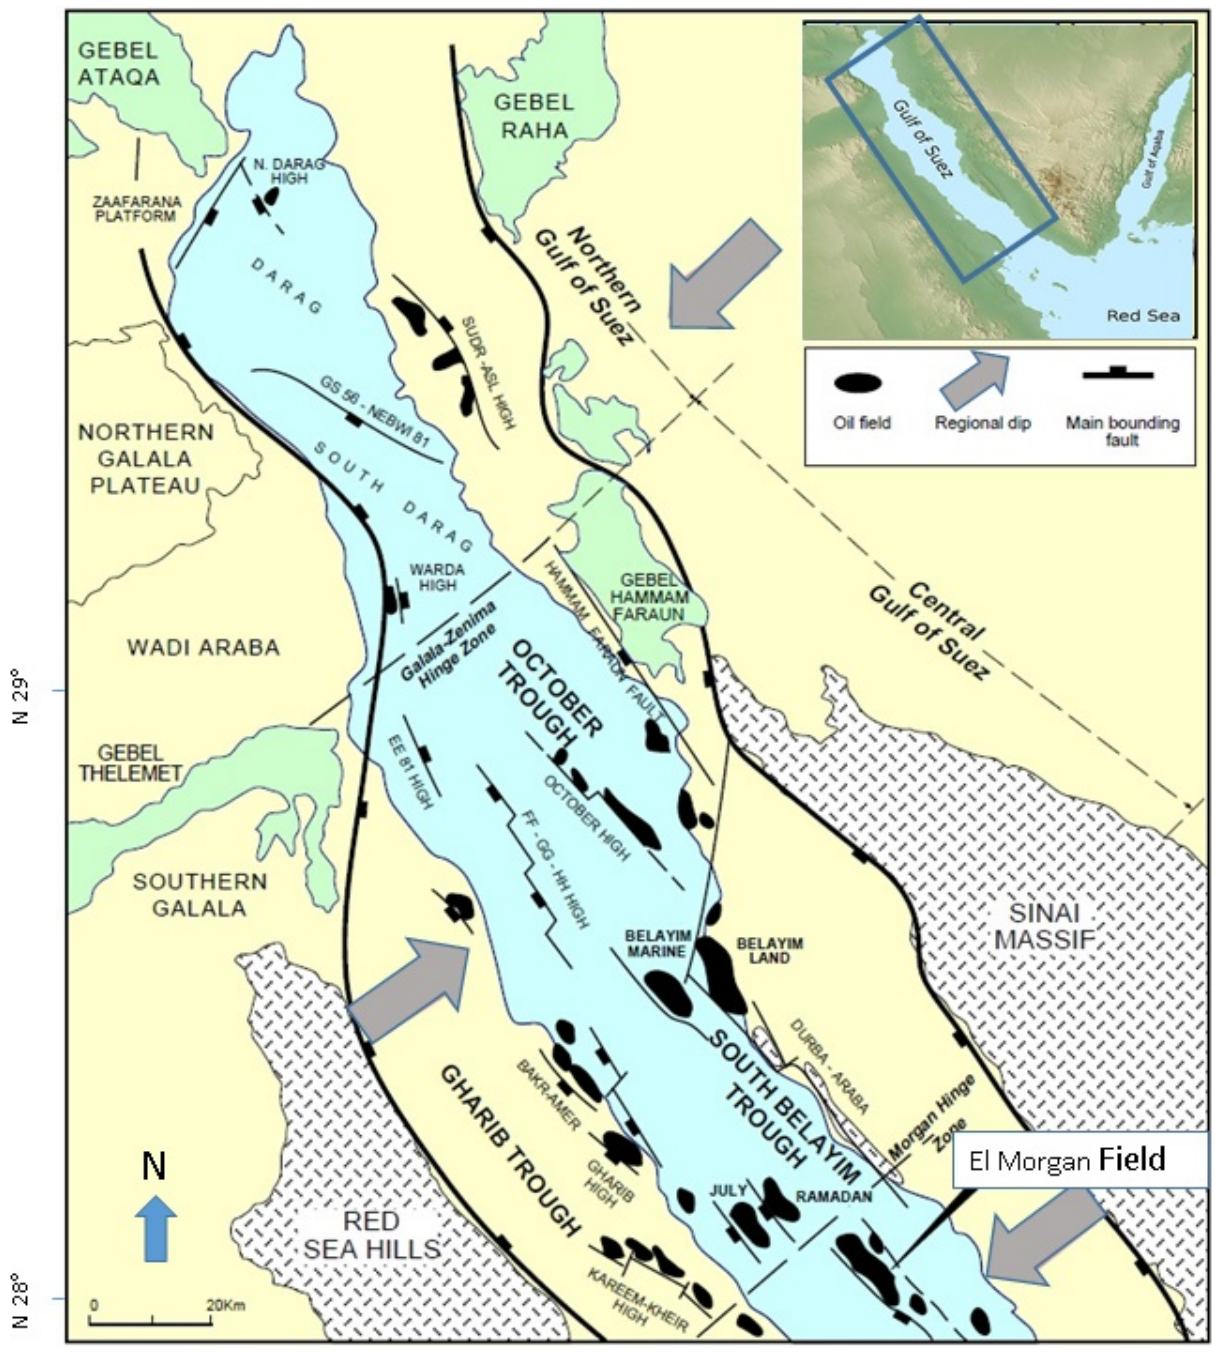
Figure 1. General location map of the Gulf of Suez Basin displays the key features of the basin, as well as the location of the El Morgan Field.